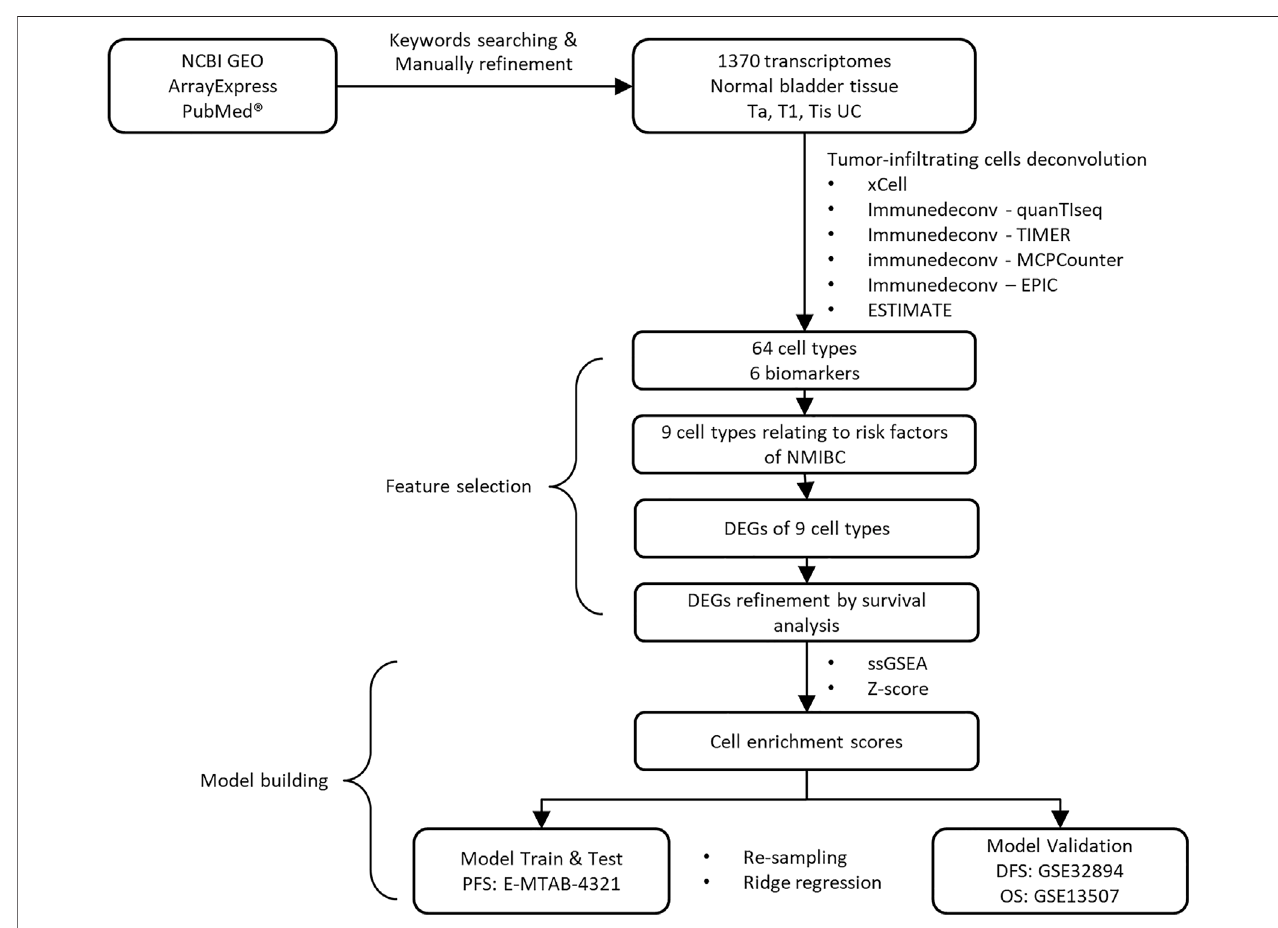
FIGURE 1 | Overview of study